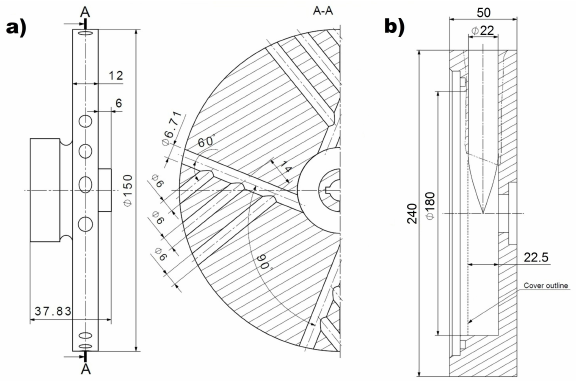
Figure 2: Dimensions of (a) basic hole impeller and (b) basic annular